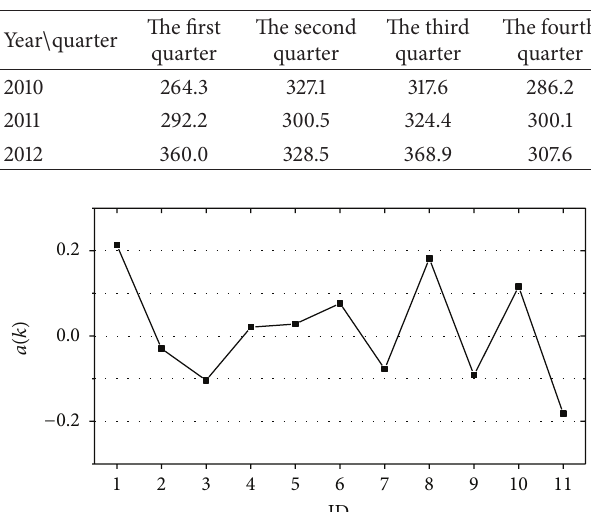
Table 1: The quarterly total water consumption by the hospitals in Wuhan City in 2010–2012 ( × 10 4 tons).